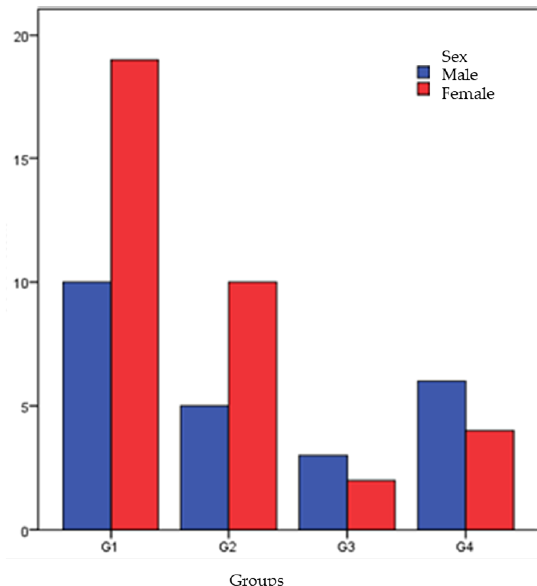
Horses were mostly mares in Group 1 and Group 2 and stallions in Group 3 and Group 4 (Figure 4).